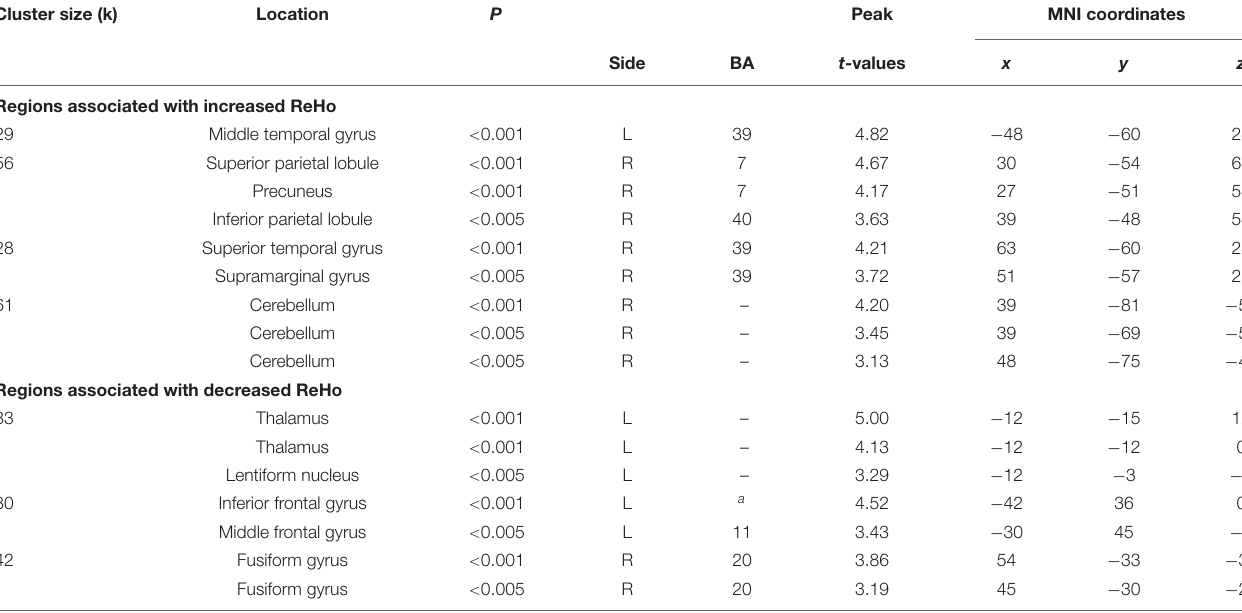
FIGURE 2 | Coronal and axial multislice views of regions showing correlations between NDQ scores and ReHo values in NM group. Color code; red, regions for which the NDQ scores were associated with increased ReHo values; blue, regions for which the NDQ scores were associated with decreased ReHo values. Significant regions were obtained with the following combination of statistical thresholds: p < 0.01 at voxel level within clusters > 26. TABLE 4 | Localization of regions showing correlations between NDQ scores and ReHo values in the CTL group. Cluster size